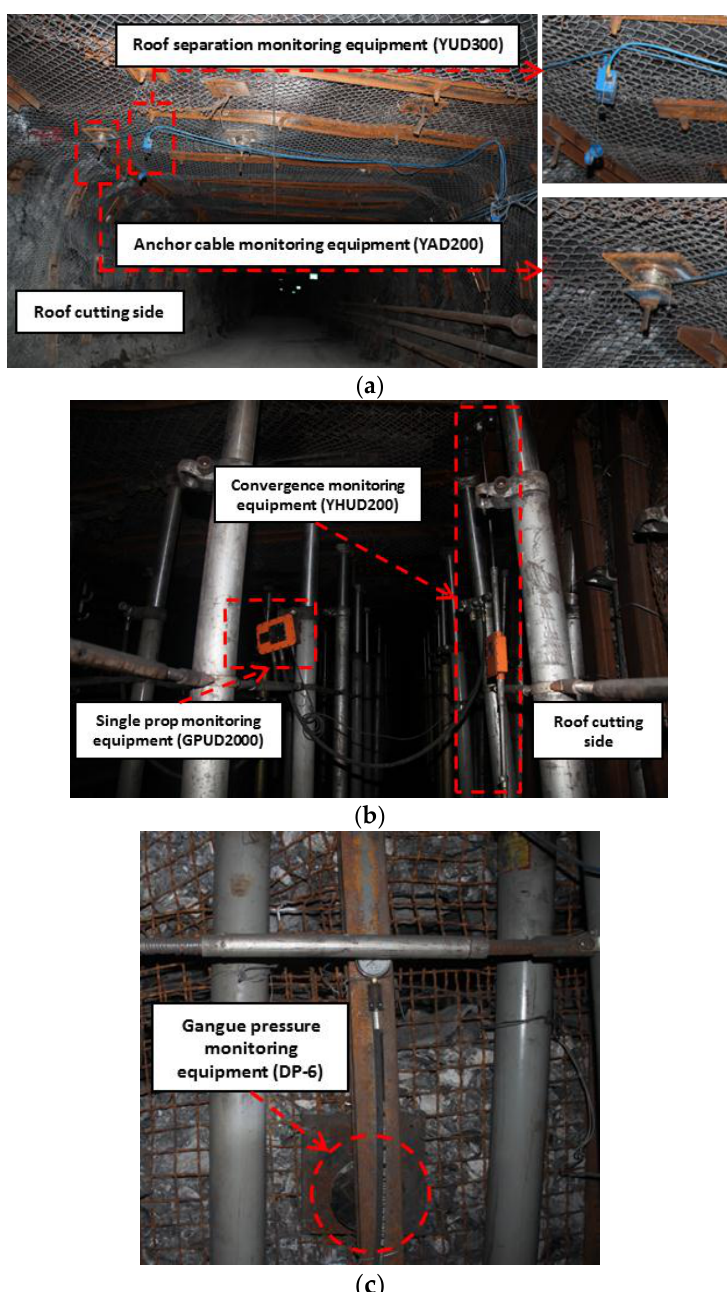
Figure 10. Monitoring equipment in GERRC: ( a ) Monitoring equipment for constant resistance anchor cable (YAD200) and roof separation (YUD300); ( b ) Monitoring equipment for single prop (GPUD2000) and convergence (YHU200); ( c ) Monitoring equipment for gangue pressure (DP - 6).